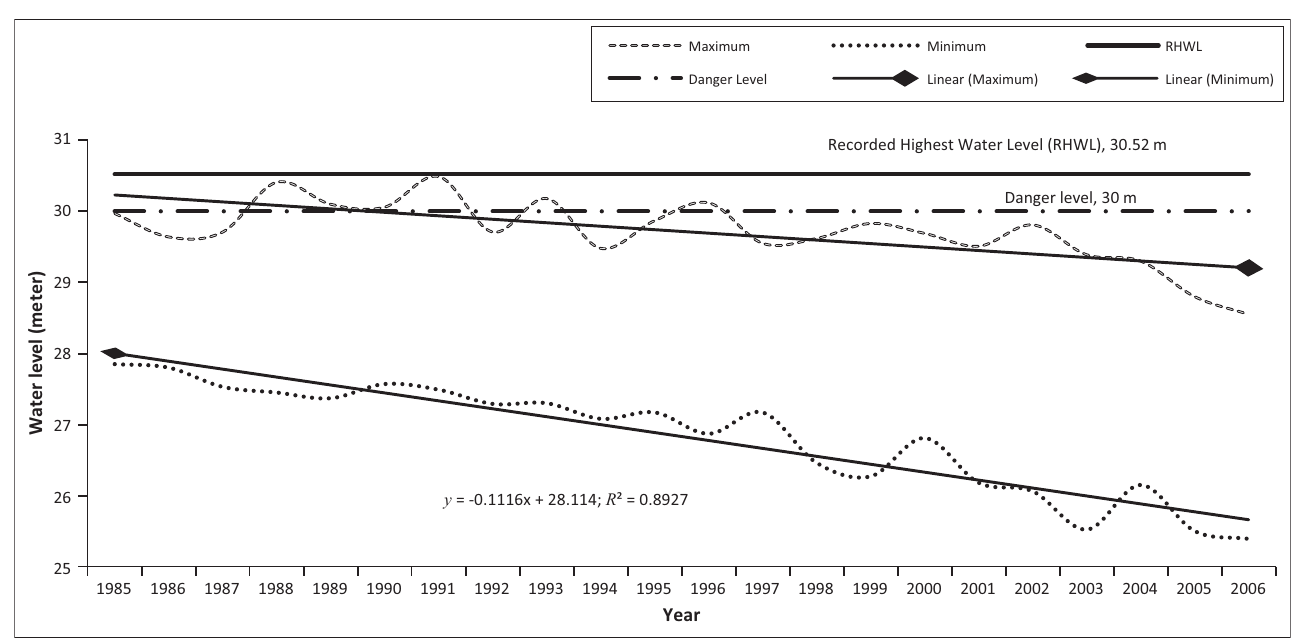
FIGURE 10: Yearly recorded maximum and minimum water level at Kaunia Station from 1985 to